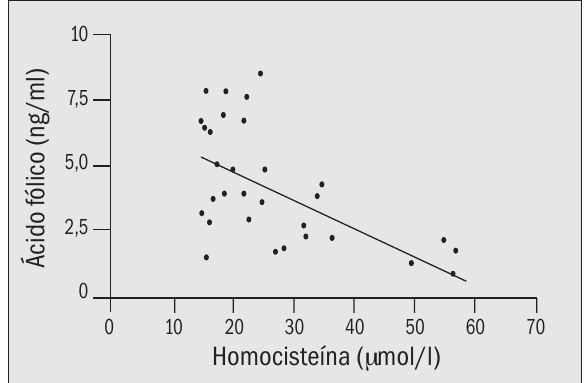
Figura 2 – Concentração plasmática de homocisteína (Hci) e ácido fólico em alcoólatras na admissão (dia 0 ). Correlação significante entre HCi e ácido